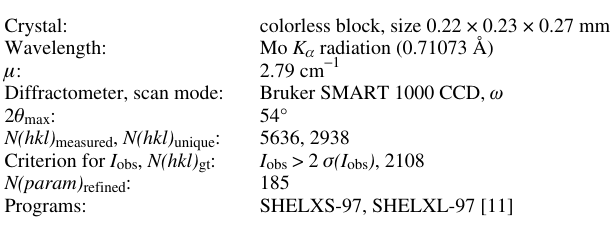
Table 1. Data collection and handling.